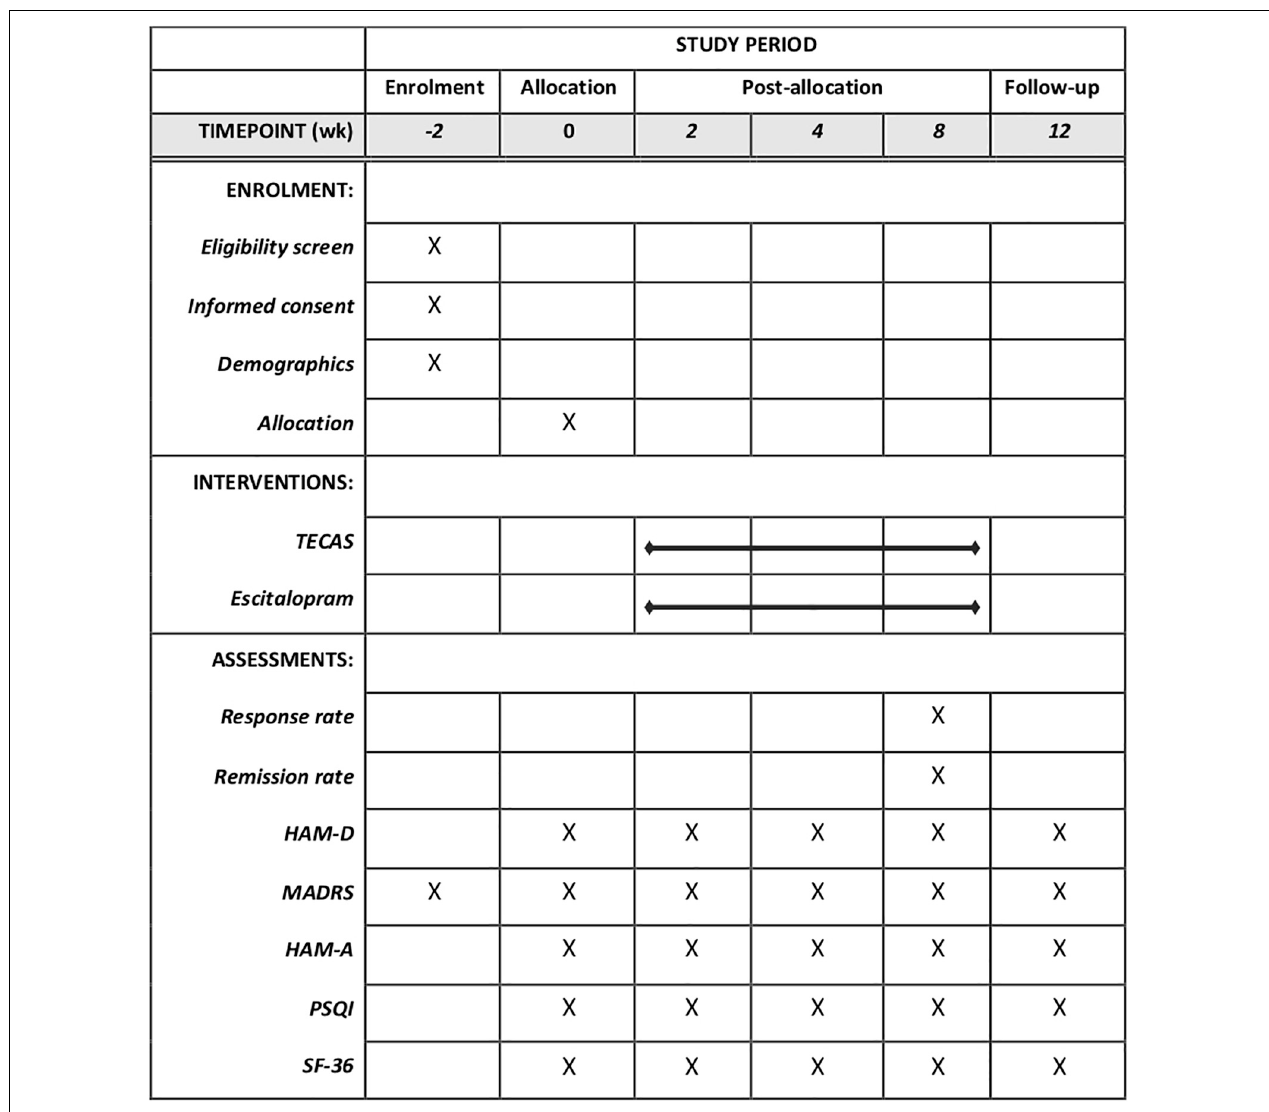
FIGURE 3 | Standard protocol items: recommendations for intervention trials (SPIRIT) schedule of enrollment, interventions, and assessment. TECAS, transcutaneous electrical cranial-auricular acupoint stimulation; HAM-D, 17-item hamilton depression rating scale; HADRS, montgomery–åsberg depression rating scale; HAM-A, hamilton anxiety rating scale; PSQI, Pittsburgh sleep quality index; SF-36, short form 36 health